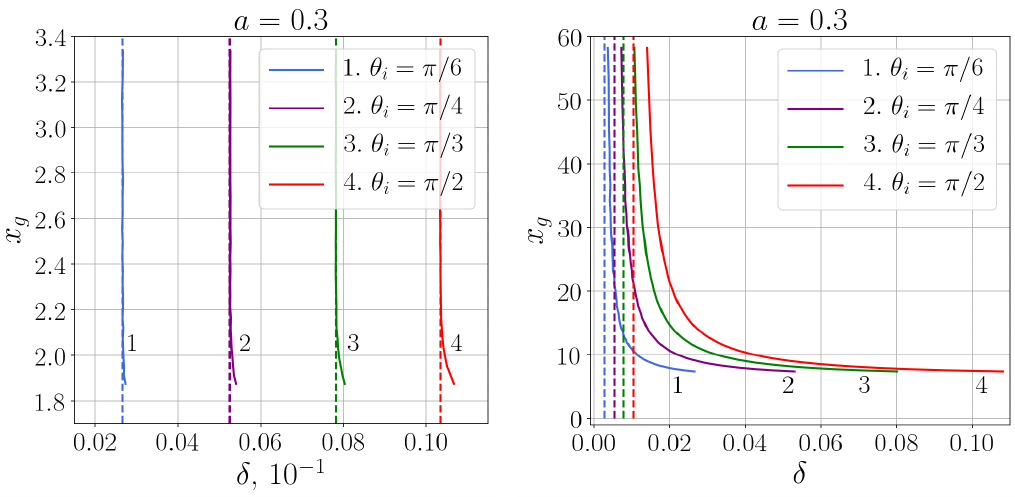
Figure 8. The case of the spin a = 0.3. Left : Relation between x g and δ for the black hole with the polarization profile (56). Right : Relation between x g and δ for the black hole with the Newtonian regularized profile